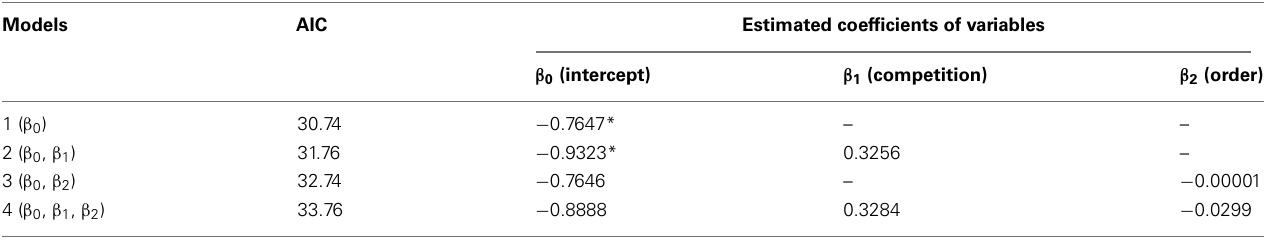
TableA1 | Numbers of choices of LL (data shown in Figure 1B) were analyzed by GLMM, and the null model that was composed of intercept ( β 0 ) and individual random difference ( r i ) was chosen.